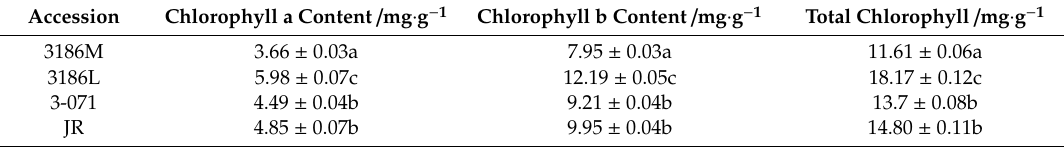
Table 4. Chlorophyll content of whitefly-treated tomato seedlings at the six-leaf stage. The measurements were made 2 weeks after treatment with whiteflies. Among them, a, b, c, and d represent di ff erent degrees of chlorophyll content. The values represent the average of three technical replicates ± SD. 3186M (tomato wo mutant, hairy), 3186L (tomato wo mutant, hairless), 3-071 (tomato ln mutant, hairless), JR (tomato cultivar Jia